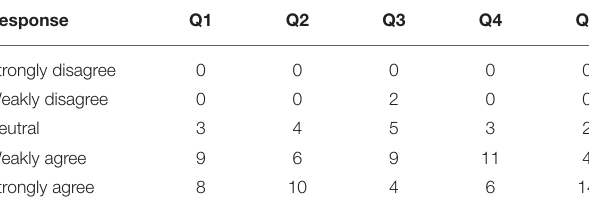
TABLE 4 | Overview of the responses provided by participants in